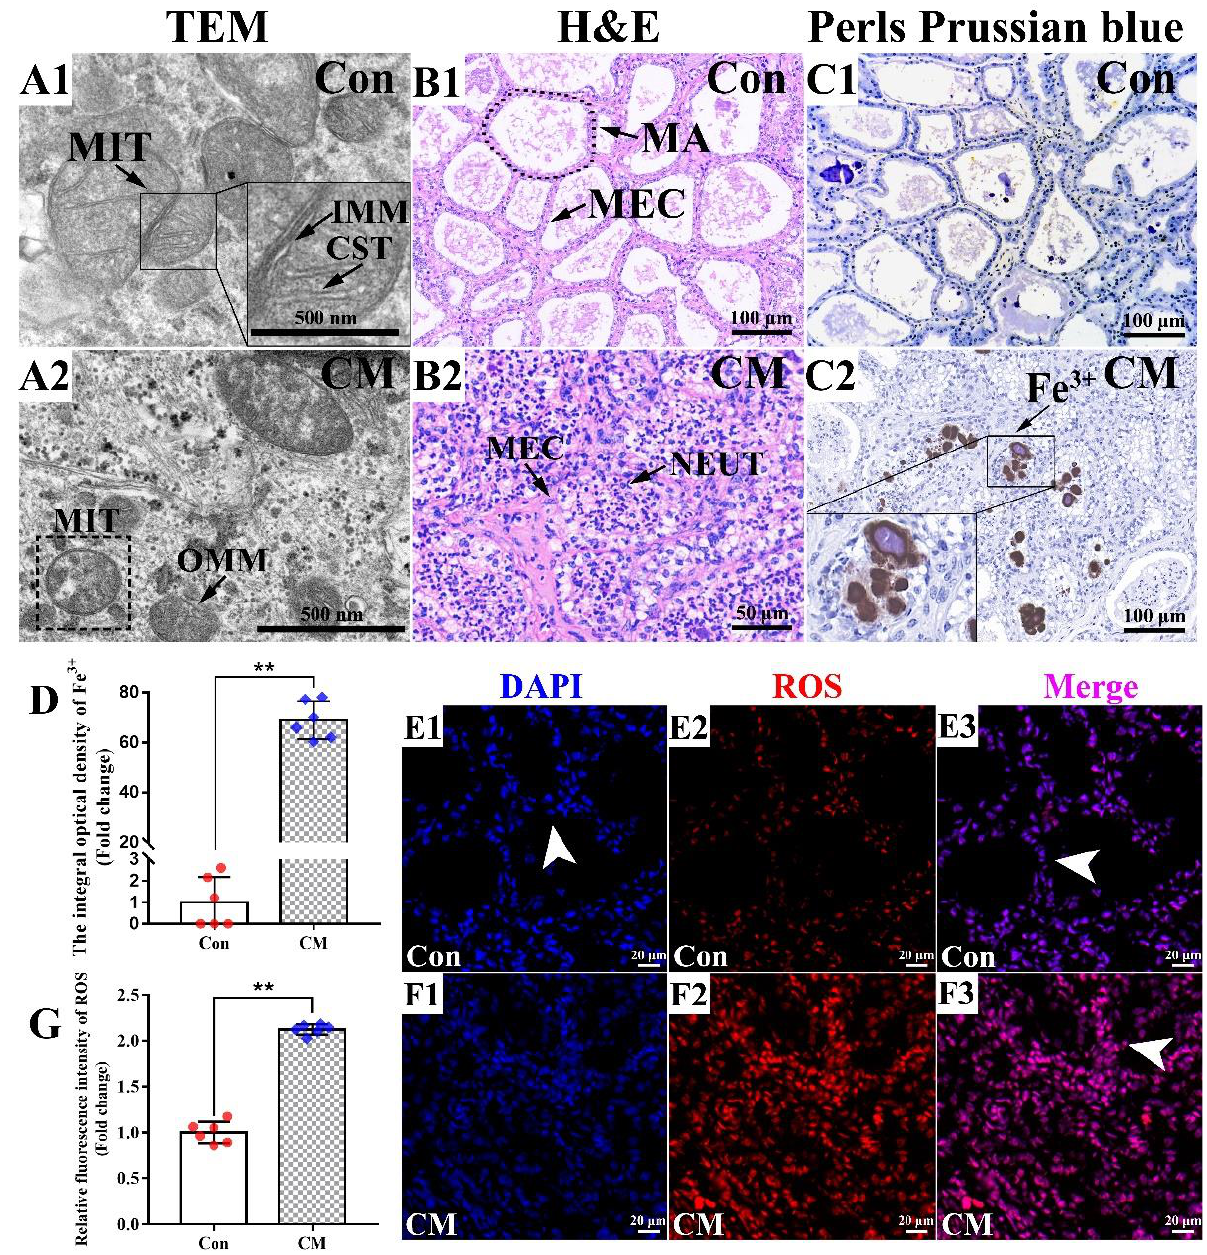
Figure 1. Phenotypes related to ferroptosis in the mammary glands of Holstein cows. ( A ) Morphology of the mitochondria was observed in the mammary glands of the control (Con) ( A1 ) and clinical mastitis (CM) ( A2 ) groups using TEM. ( B ) Morphological structures of the alveoli in mammary glands of the Con ( B1 ) and CM ( B2 ) groups were observed using H&E staining. ( C ) Observation of ferric iron (Fe 3+ ) concentration variation in the mammary glands of the Con ( C1 ) and CM ( C2 ) groups using Perls plus DAB staining. ( D ) IOD values of Fe 3+ in the Con and CM groups. ( E , F ), ROS immunofluorescent signals in the mammary glands of the Con ( E1 – E3 ) and CM ( F1 – F3 ) groups. ( G ) IOD values of the ROS in the mammary glands of the Con and CM groups. TEM, transmission electron microscopy. MIT, mitochondria. IMM, inner mitochondrial membrane. CST, mitochondrial cristae. OMM, outer mitochondrial membrane. H&E, hematoxylin–eosin staining. MA, mammary alveoli. MECs, mammary epithelial cells. NEUT, neutrophil. Con, control. CM, clinical mastitis. IOD, integral optical density. White arrow represents MECs. Scale bar of 500 nm, 50 µ m, 100 µ m and 20 µ m represents 20,000 × , 400 × , 200 × and 630 × , respectively. Statistical analyses: Wilcoxon rank sum test, α = 0.05. Data are presented as median (rank). ** represents p < 0.01.